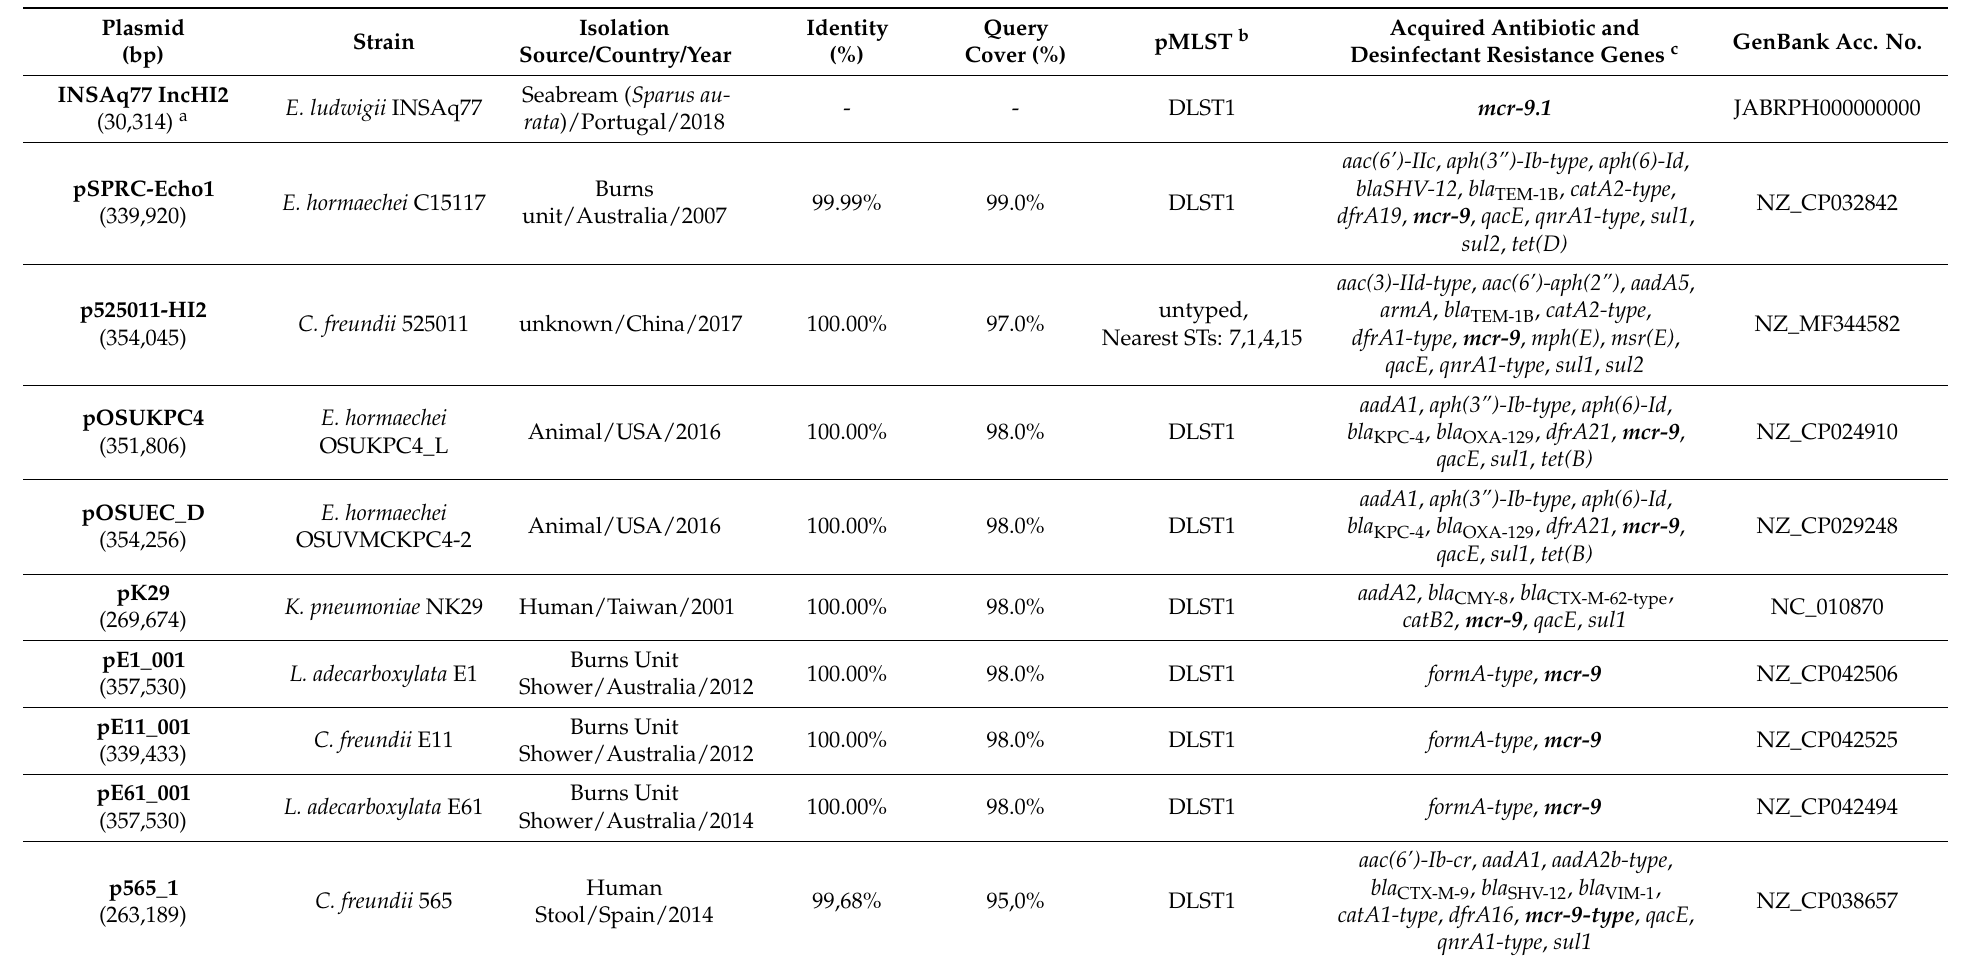
Table 2. Comparison of the INSAq77 mcr-9 -containing contigs with the top nine IncHI2 mcr-9 -harboring plasmids showing the highest identities (>99.0%, E-value 0.0, query coverage